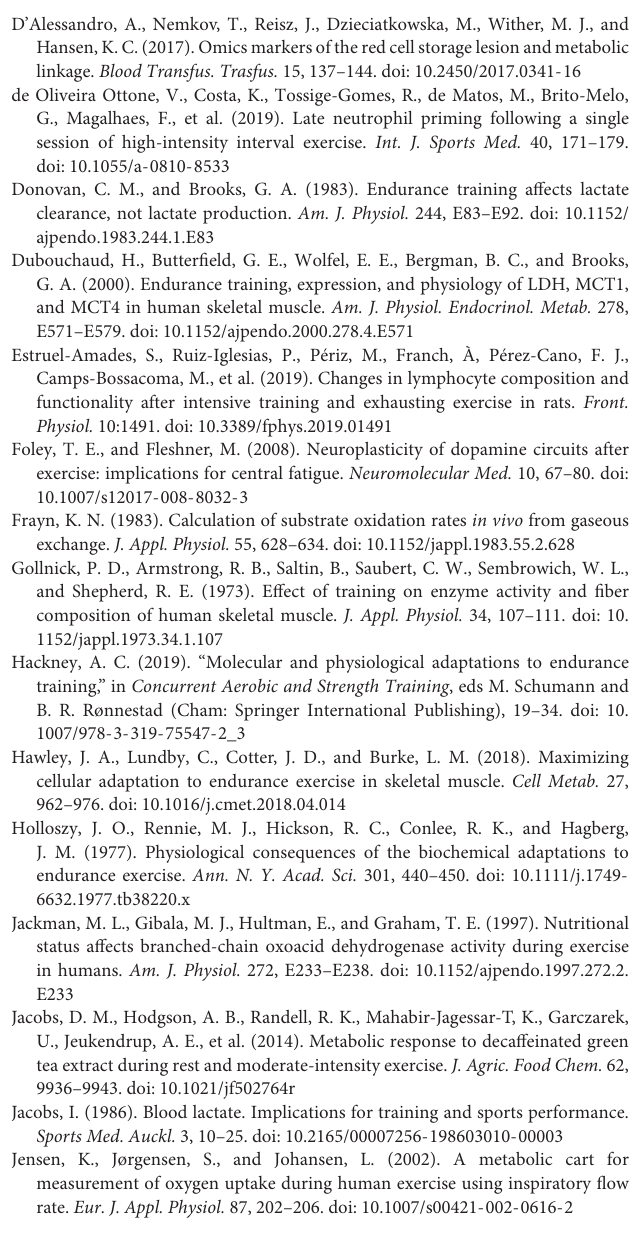
TABLE S1 | A table of the physiological and raw metabolomics data is provided. For the metabolomics data, information is included for the compound name, TABLE S2 | A table of Spearman Correlation Coefficients for the Gold Network, Silver Network, and the Diverging Network (i.e., the difference between the Gold and Silver Networks) is provided. DATA SHEET S1 | A heat map of metabolite hierarchical clustering analysis is shown. Rows and columns were hierarchically clustered according to 1 minus the Spearman rank correlation. Metabolite values are depicted as Z-scores, with the values color coded from row minimum to maximum on a gradient from blue to red,